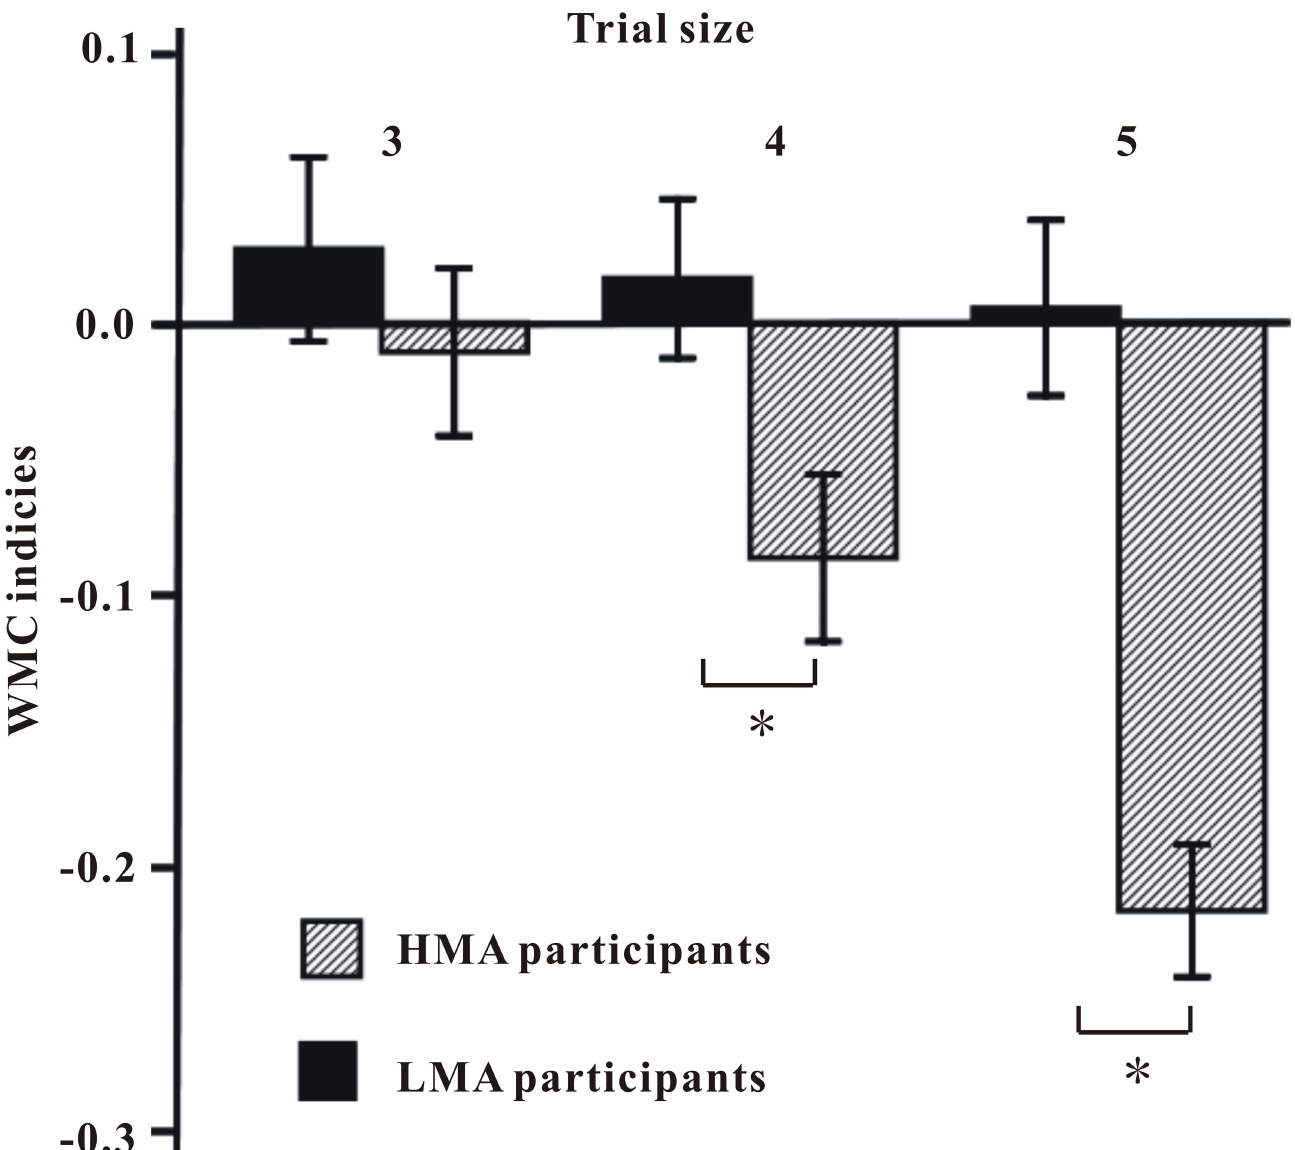
Fig 2. Mean ( ± 1SE) WMC indices (i.e., WMC scores for trials under the math-related condition minus WMC scores for trials under the valence-neutral condition) for trial sizes 3–5 for HMA participants compared with LMA